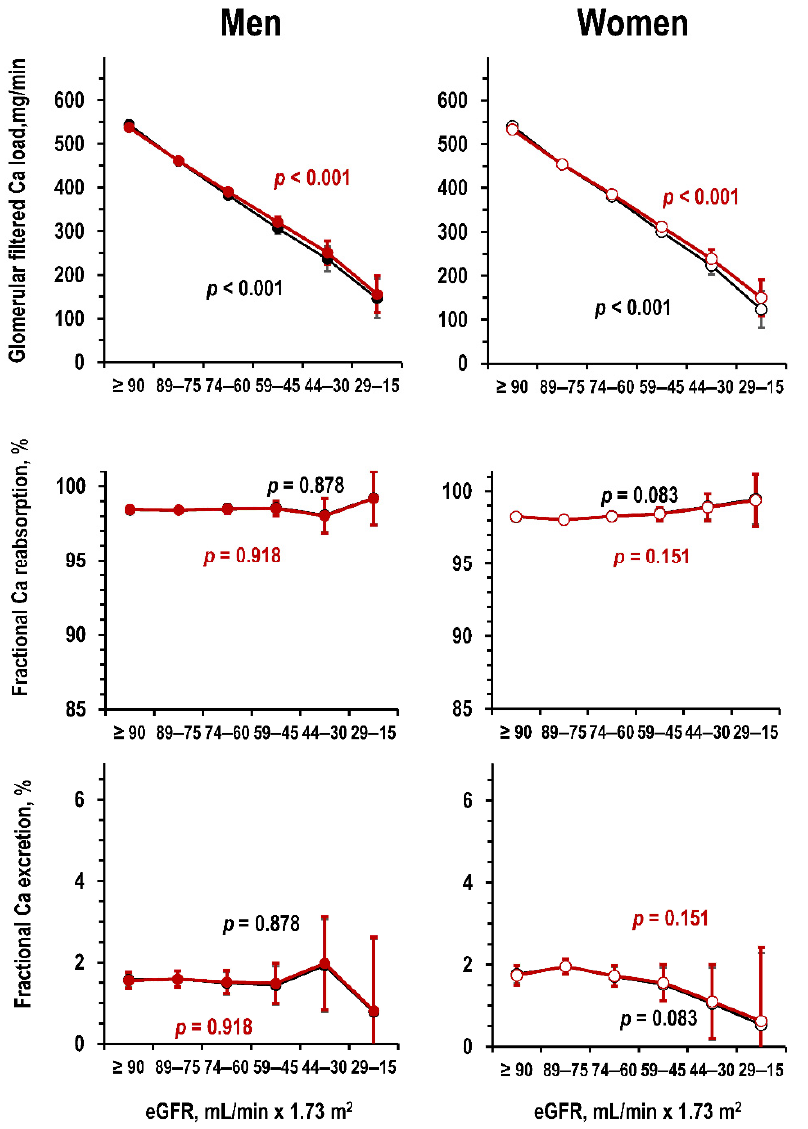
Figure 2. Moli-sani dataset: mean and 95%CI in men and women ( left panels and right panels, respectively) by eGFR stratum of glomerular filtered load of Ca ( upper panels), of fractional tubular reabsorption of Ca ( central panels), and of fractional excretion of Ca ( lower panels) in uni-variate ANOVA and in ANOVA controlled for age (black line and red line, respectively). Number of individuals per eGFR stratum from left to right: men = 195, 168, 88, 30, 5, and 2—women = 139, 175, 107, 36, 8, and 2. No individual had eGFR < 15 mL / min × 1.73 m 2